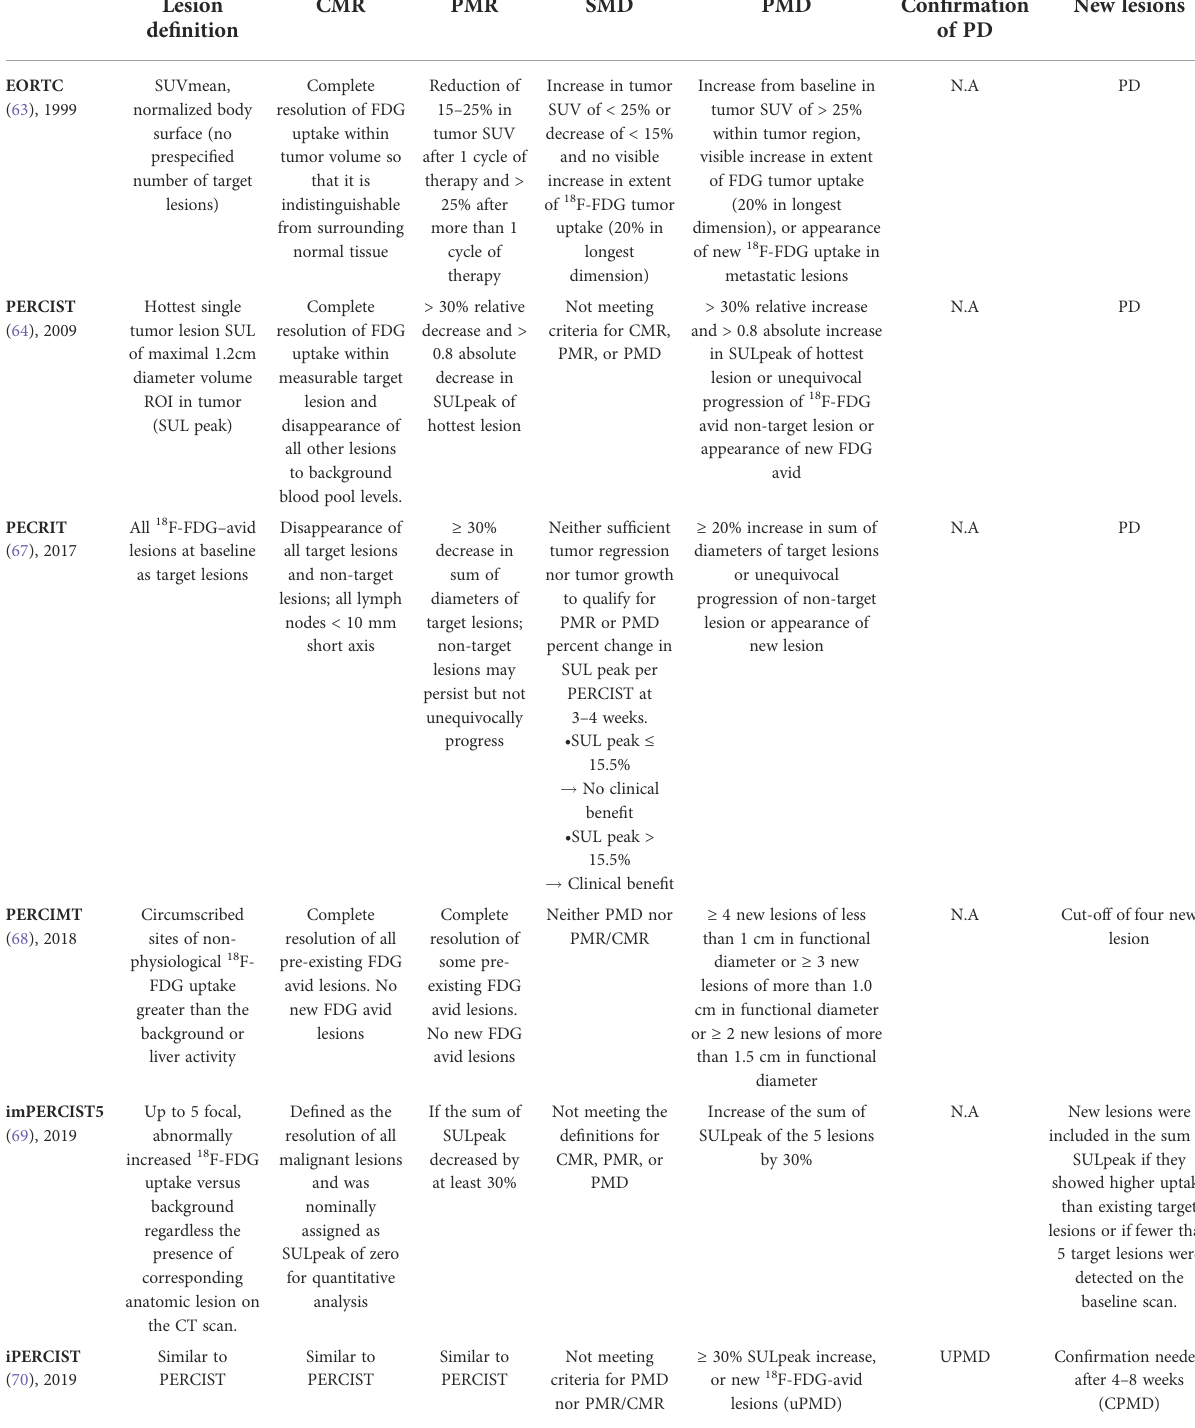
TABLE 2 Metabolic criteria for the assessment of response to